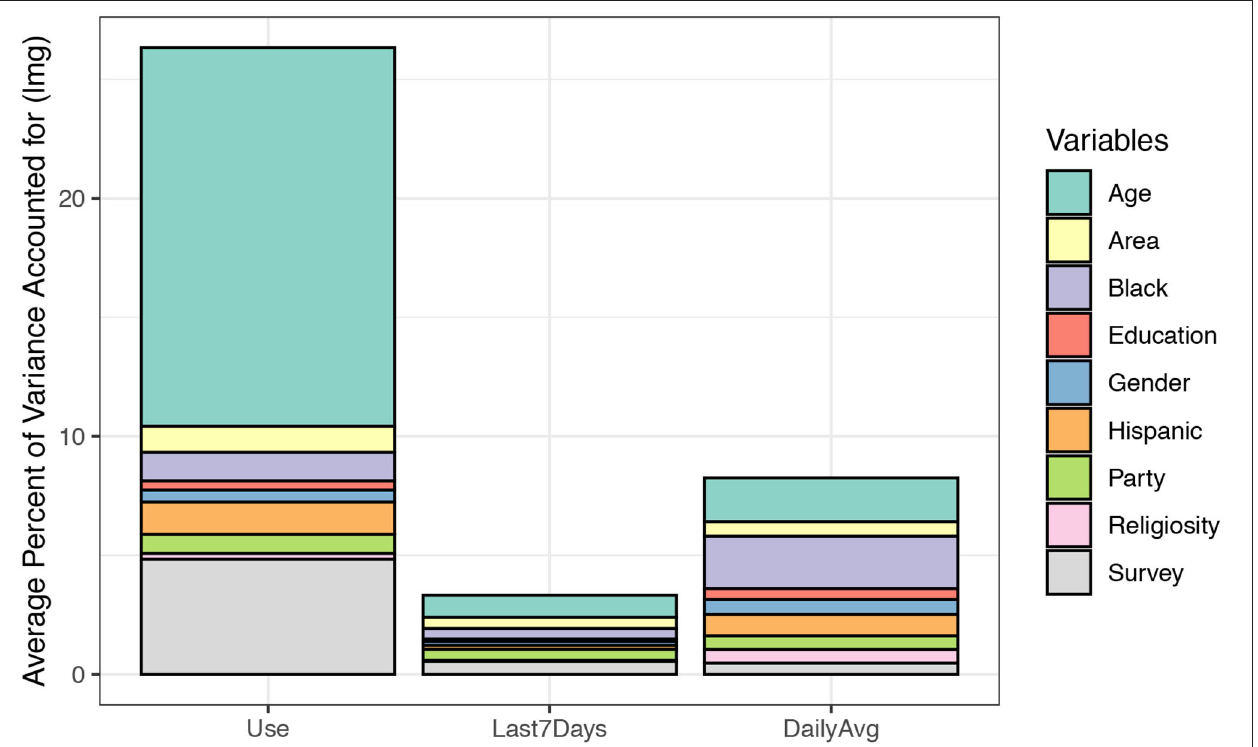
Frontiers in Communication |